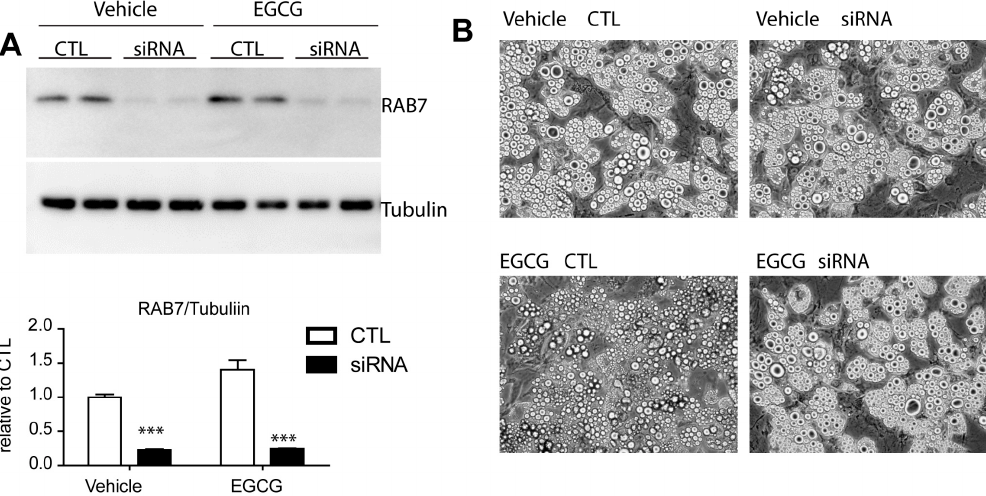
Figure 6. Effects of knockdown of RAB7 on EGCG induced reduction in lipid content in adipocytes. ( A ) Immunoblot analysis of RAB7 in adipocytes differentiated from C 3 H 10 T1/2 treated with siRNA or scrambled sequence controls. Two-way ANOVA revealed significant main effects of siRNA knockdown ( p < 0.0001) and EGCG treatment ( p = 0.0122) in RAB7 expression and significant interaction of siRNA knockdown and EGCG treatment ( p = 0.0206). Significant differences between control and siRNA were determined by post-hoc pairwise comparison with Bonferroni correction (mean ± SEM; n = 4 per condition, *** p < 0.001) ( B ) Representative images of adipocytes differentiated from C 3 H 10 T1/2 treated with vehicle or EGCG (10 µ M) for 24 h. ( n = 4, means ± SE; *** p < 0.001).